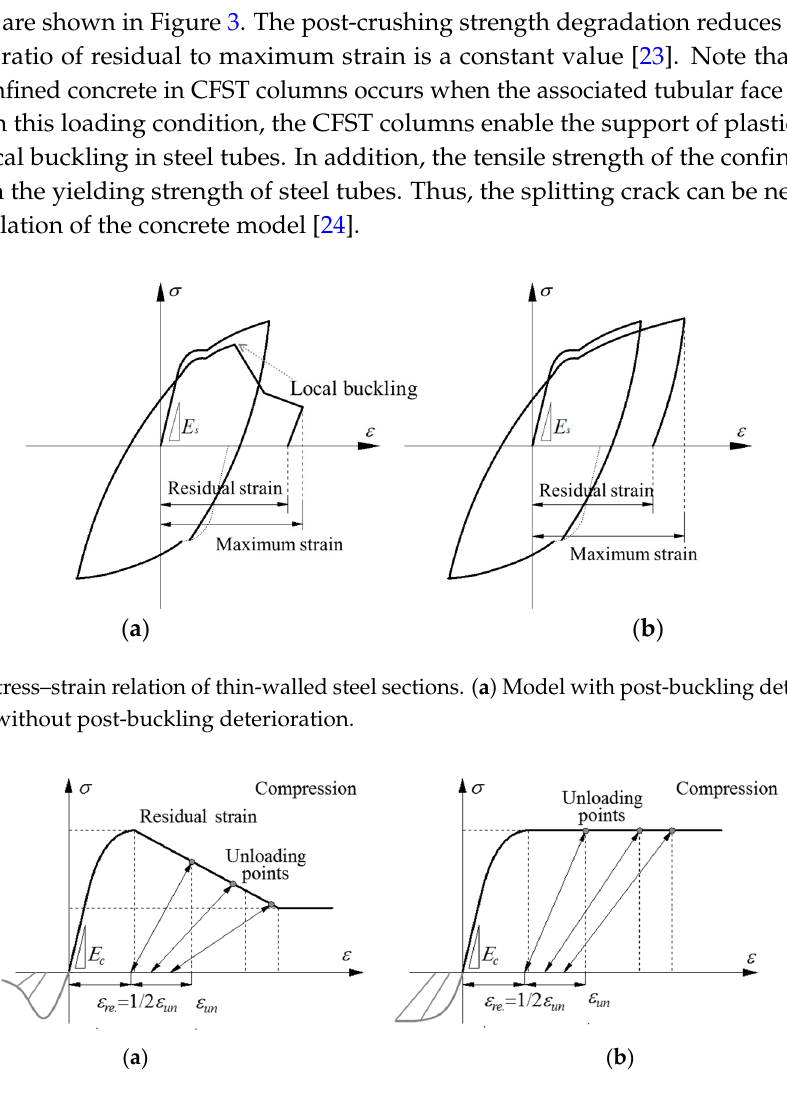
Figure 3. Stress–strain relation of confined concrete. ( a ) Model with post ‐ crushing deterioration; ( b ) Model without post ‐ crushing deterioration.